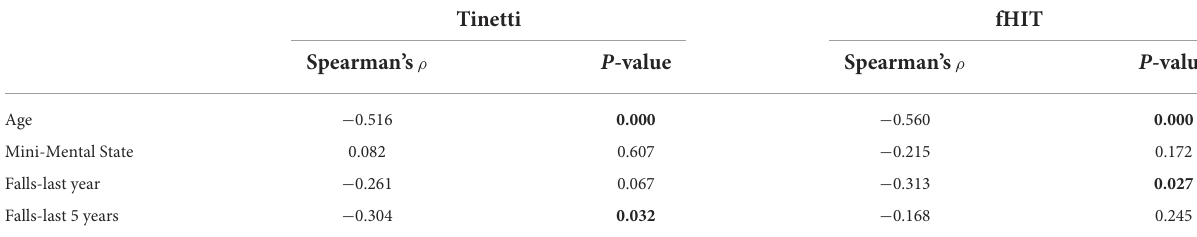
TABLE 2 Non-parametric correlations between Tinetti/fHit scores and age, Mini-Mental State score, falls occurred during the last year and falls occurred during the last 5 years.